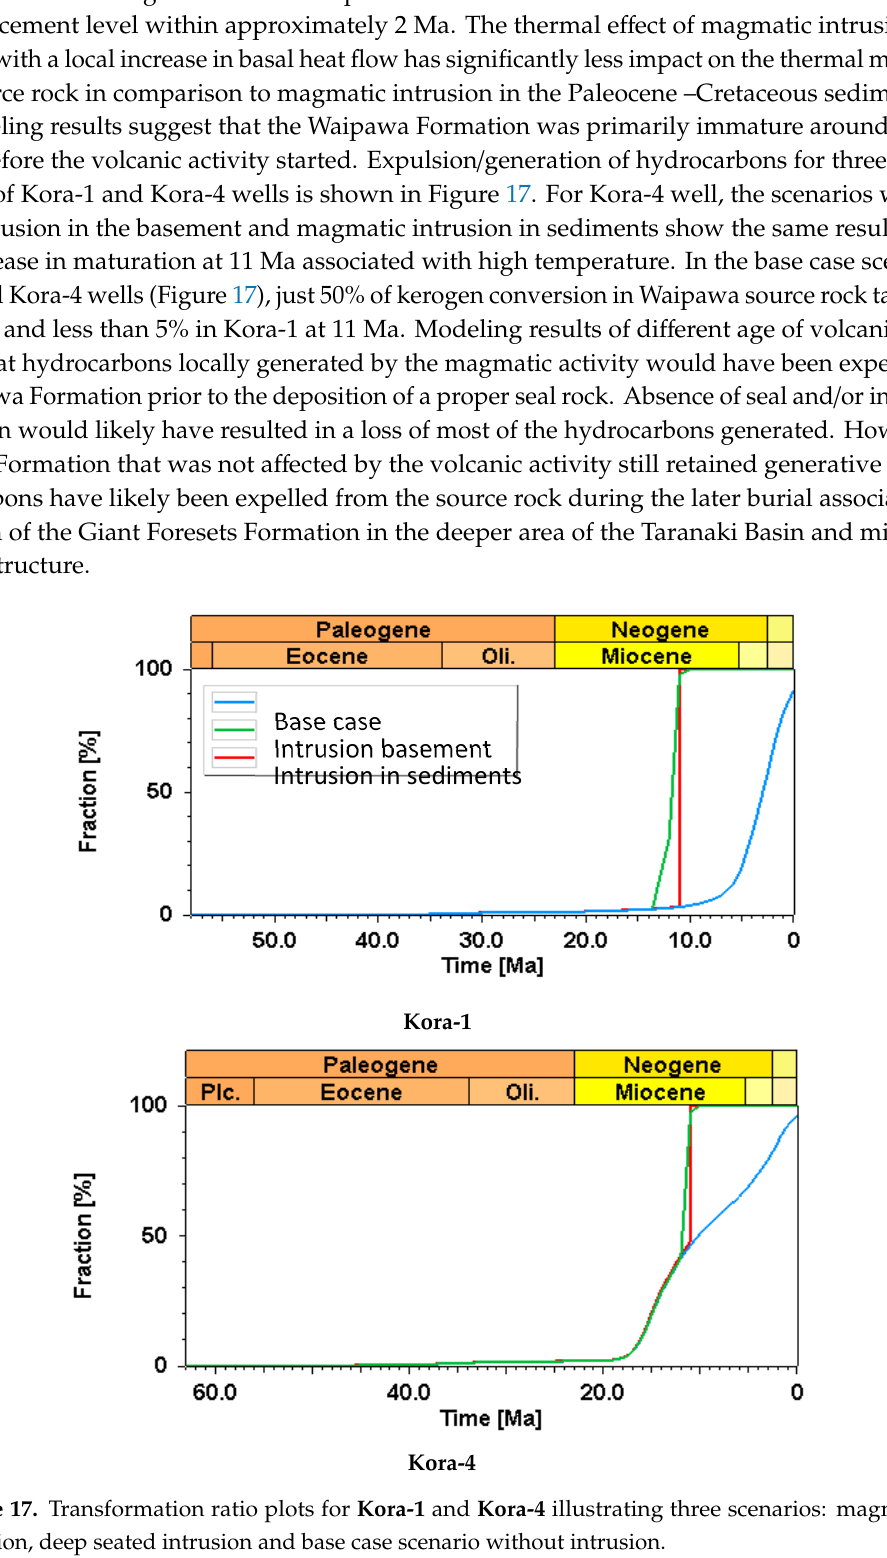
( B ) Figure 18. 1D models of Kora-1 well showing the sensitivity of the system to changes in ( A ) change of the basal heat flow during volcanic activity, and ( B ) sill intrusion thickness.